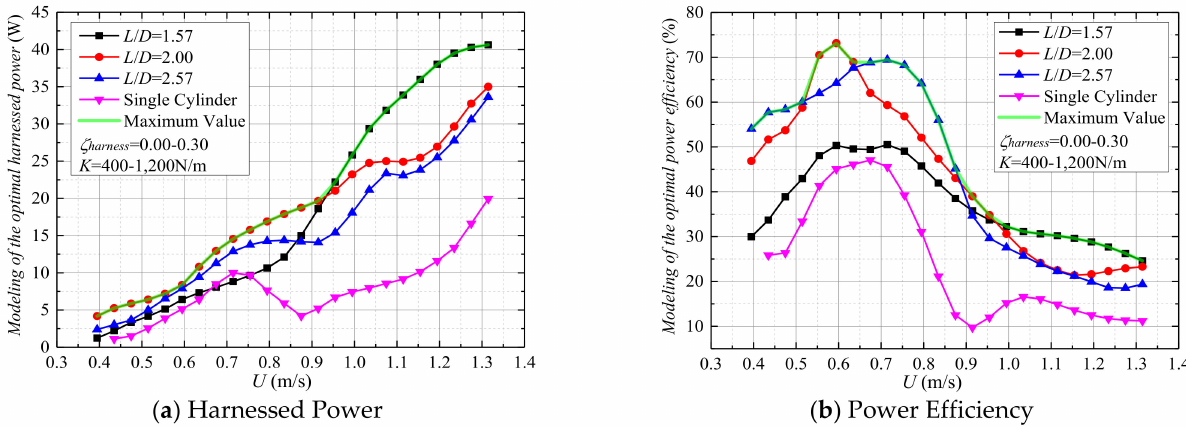
Figure 14. The optimal power and efficiency curves for spacing L / D = 1.57, 2.00 and 2.57: ( a ) Harnessed power; ( b ) Power efficiency. Model is based on K = 400–1200 N/m and 0.00 < ζ harness <